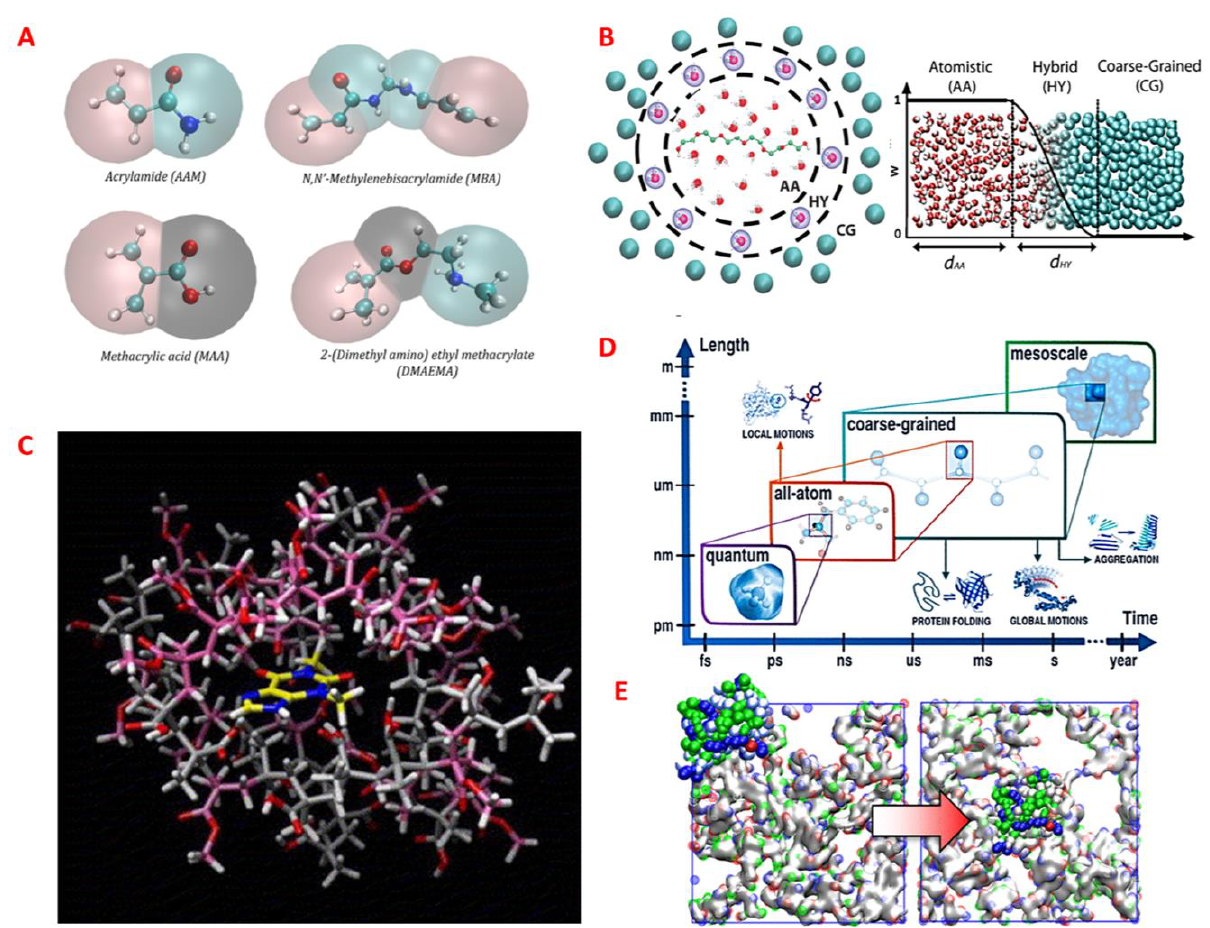
Figure 3. ( A ) Atomistic and CG representation of the hydrogel monomers. Solid beads represent the atomistic model and correspond to carbon, nitrogen, oxygen, and hydrogen in cyan, blue, red, and white, respectively. Translucent beads represent the different types of CG beads (polar, neutral, or apolar). Reprinted with permission from [54], Copyright 2018, American Chemical Society. ( B ) A solvated macromolecule surrounded by water molecules is shown schematically on the left, with the water molecules represented atomistically close to the macromolecule (denoted as AA zone) and in a CG mode that is farther from the macromolecule (denoted as CG zone), with a hybrid (HY) zone in between the AA and CG zones. This transition is shown in the right figure as a function of radial distance to the macromolecule. Reprinted with permission from [130], Copyright 2016, American Chemical Society. ( C ) Atomistic models of copolymer structures constructed using methacrylic acid (MAA) and methylmethacrylate (MMA) and observed for interaction with theophylline (THO). THO molecule is visible inside the binding pocket. Color scheme: THO carbons (yellow), MAA carbons (gray), MMA carbons (pink), oxygens (red), nitrogens (blue), hydrogens (white). Reprinted from [128], Copyright 2006, with permission from Elsevier. ( D ) Application domains for molecular modelling at various resolutions, including quantum, all-atom, coarse-grained, and mesoscale. Approximate time scales and system sizes (lengths) are shown on the plot. By combining tools of various resolutions into multiscale schemes, the application ranges that are covered, can be expanded. Reprinted with permission from [131], Copyright 2016, American Chemical Society. ( E ) Coarse-grained simulation of protein-imprinted hydrogels. Reprinted with permission from [54], Copyright 2018, American Chemical